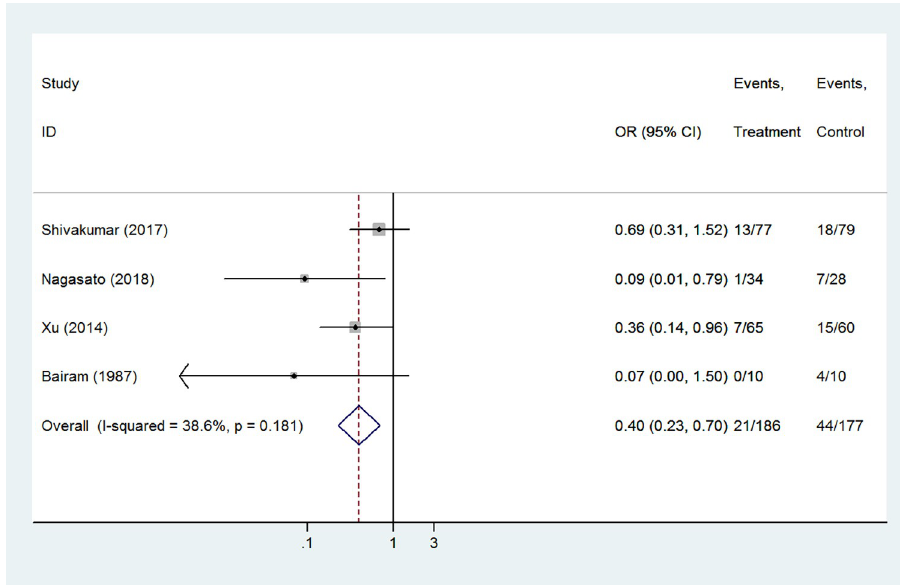
Fig 4. Forest plot of showing the effects of caffeine vs aminophylline on feeding intolerance.